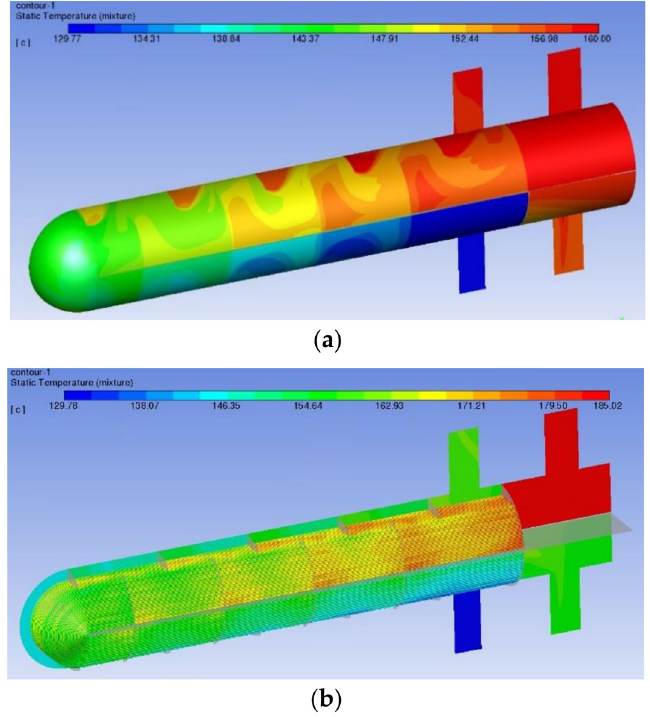
Figure 17. Temperature distribution of heat exchanger: ( a ) temperature of the tube side and ( b ) temperature of the shell side.